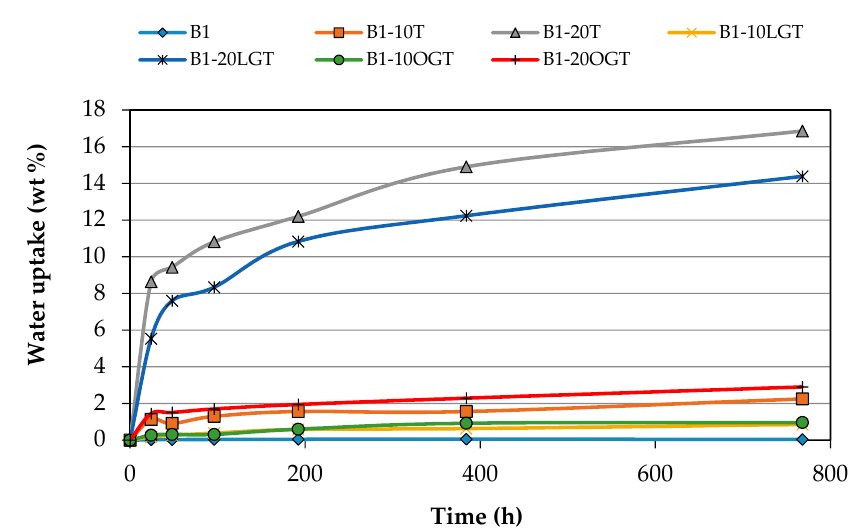
Polymers 2018 , 10 , x FOR PEER REVIEW Figure A1. Water absorption (wt %) by the BioPE1-based filaments during 32 days of water immersion.